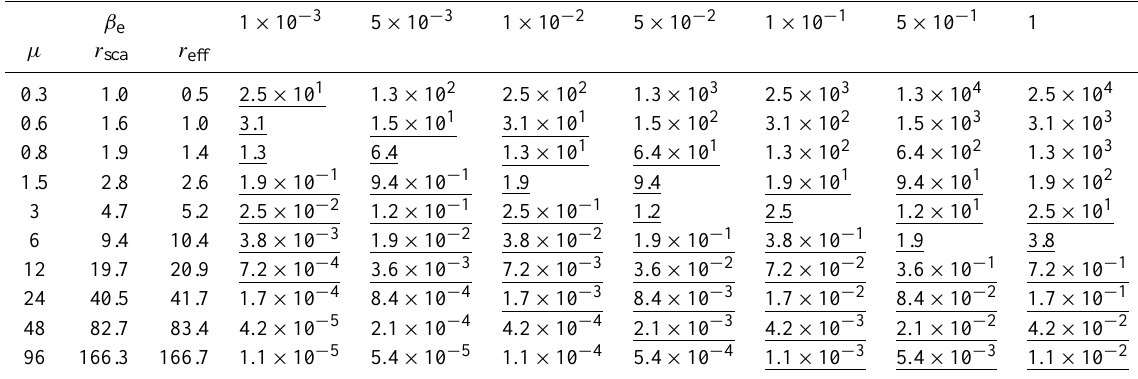
Table 3. Ice: number concentration n in cm − 3 for different median radii µ in µm and extinction coefficients β e in km − 1 . Realistic number concentrations in the order of magnitude that were reported by Krämer et al. (2009) and Tian et al. (2010) are underlined. β e 1 × 10 −